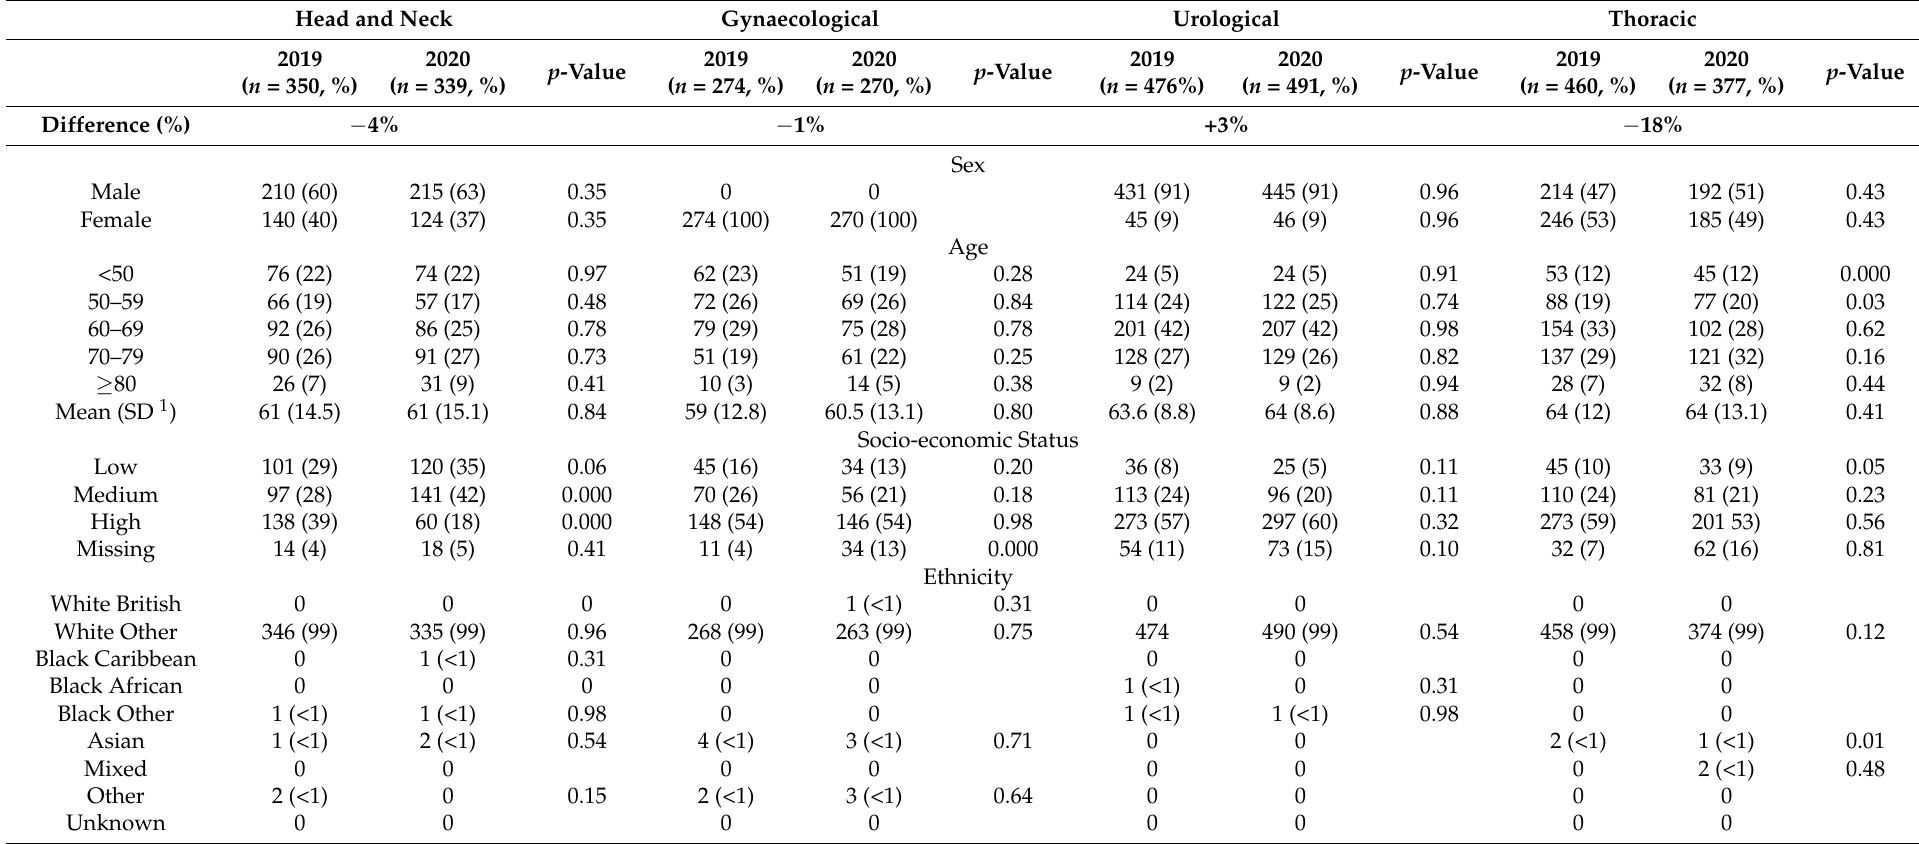
Table 1. European Institute of Oncology, IRCCS (IEO) patient characteristics of cancer patients receiving radical surgery between 1 March 2019–30 September 2019 and 1 March 2020–30 September 2020, divided by cancer